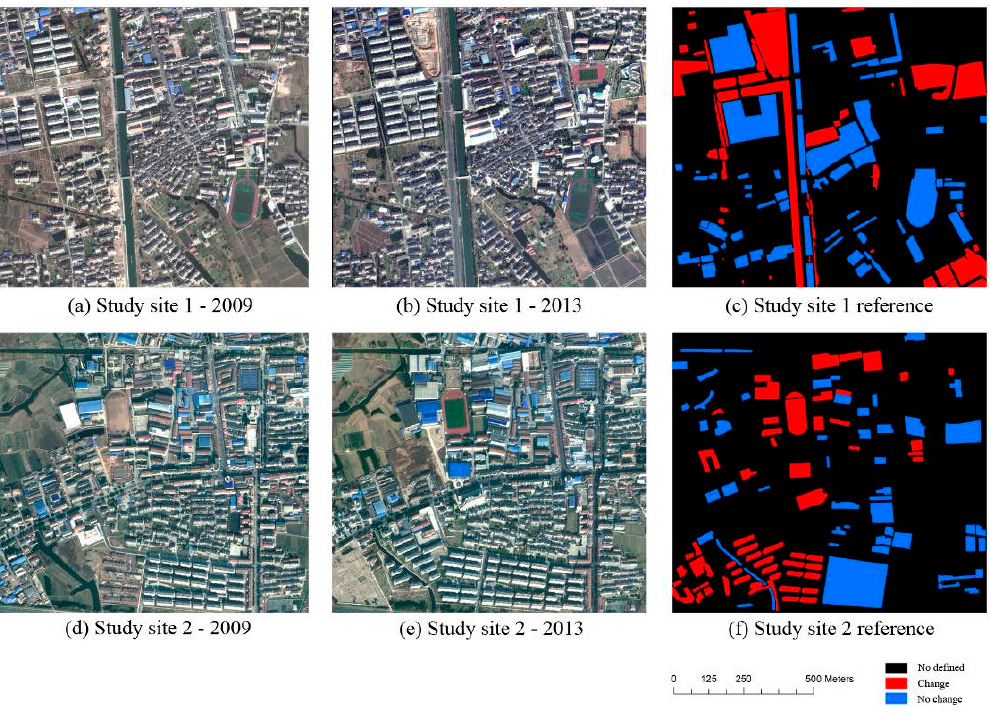
Figure 3. Study sites: ( a , b ) are WorldView-2 true-colour images for Study site 1; and ( c ) shows the reference polygons from manual interpretation; ( d , e ) are WorldView-2 true-colour images for Study site 2; and ( f ) shows the reference polygons for Study site 2. In the ground reference maps, the red patches indicate changed areas while blue patches indicate unchanged areas.